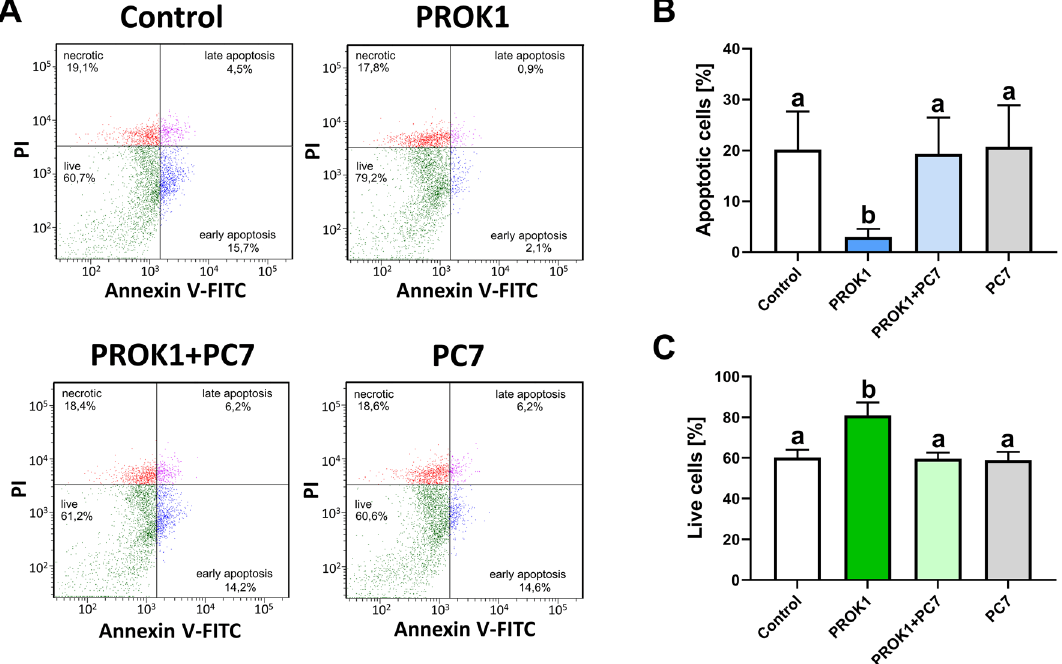
Figure 5. The effect of prokineticin 1 (PROK1) on apoptosis and viability of the porcine luteal cells collected on Day 12 of the estrous cycle. Three cell phenotypes were distinguished: live (annexin V-negative/PI-negative), apoptotic (sum of early apoptotic—annexin V-positive/PI-negative and late apoptotic—annexin V-positive/ PI-positive), and necrotic cells (annexin V-negative/PI-positive). ( A ) Representative scatter plots of PI (y-axis) vs. annexin V (x-axis) with percentages of individual cell phenotypes are shown in panels on the right of the graphs; ( B ) apoptotic cells, and ( C ) live cells. Isolated cells were treated with the control (vehicle) or PROK1 (40 nM) in the presence or absence of prokineticin receptor 1 (PROKR1) antagonist (PC7; 1 µM). The assay was performed by using fluorescence-activated single-cell sorting based on phenotypes detected by flow cytometry. Data are presented as means ± SEM. Different lowercase letters (a, b) indicate statistically significant differences between groups ( p <